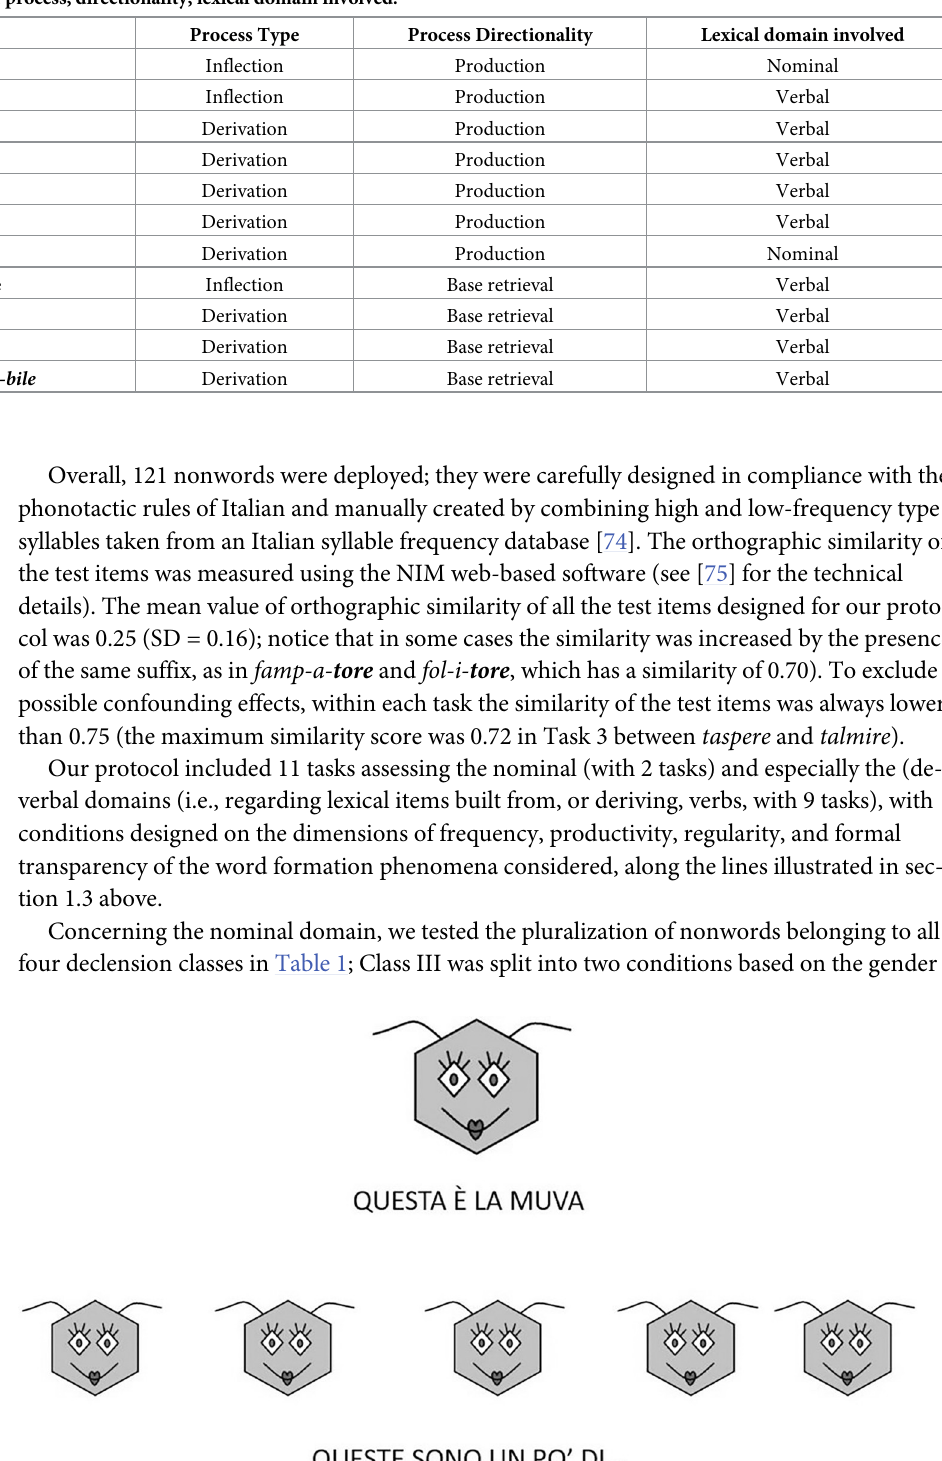
Table 4. Characteristics of the 11 tasks: Type of process, directionality, lexical domain involved.